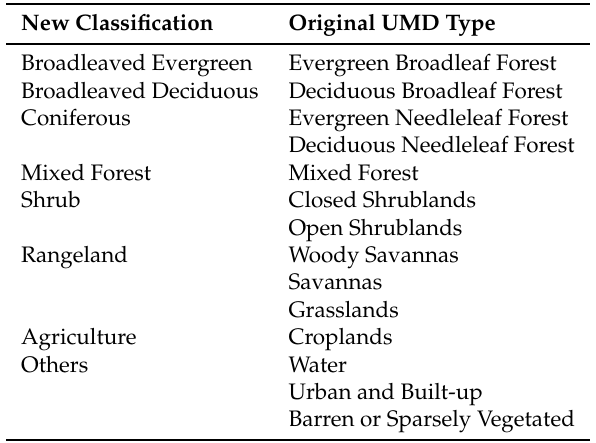
Table 3. Mapping between the original University of Maryland (UMD) land cover types and the new classifications for the geographic